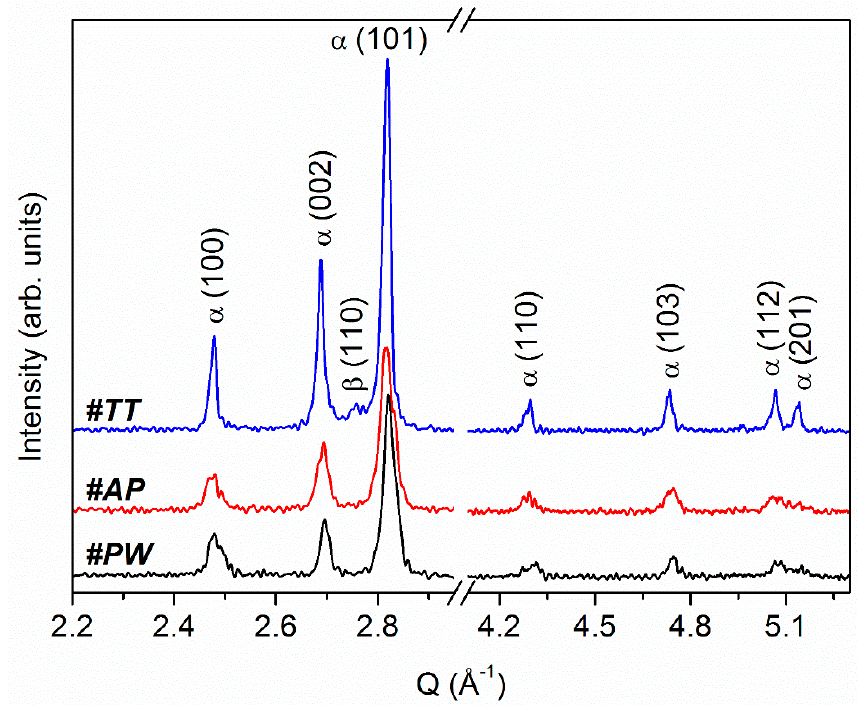
Figure 3. XRD patterns of samples in the same scattering vector range of neutron diffraction analysis.